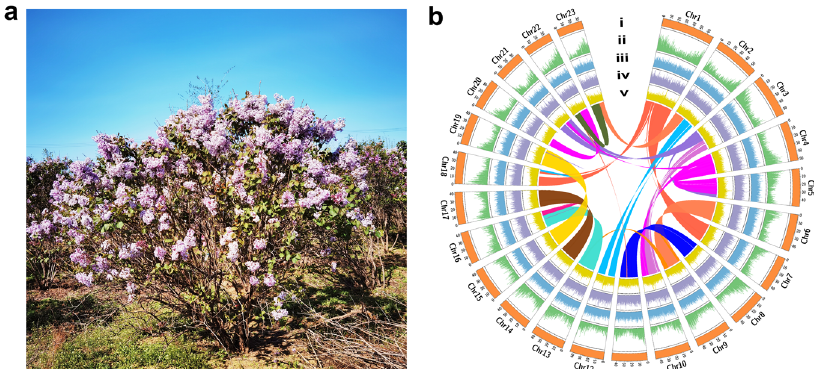
Fig. 1 Image and genome characterization of Syringa oblata . a Photo of S . oblata in Beijing, China (by Bo Ma, 2021). b Twenty-three pseudochromosomes were ordered by size. Chr1-Chr23 refers to the 23 assembled chromosomes. (i) Assembled chromosomes (Mb, orange); (ii) Gene density (green); (iii) Transposon density (blue); (iv) Tandem repeat density (purple); (v) GC content (yellow); Line in the center of the circle represent